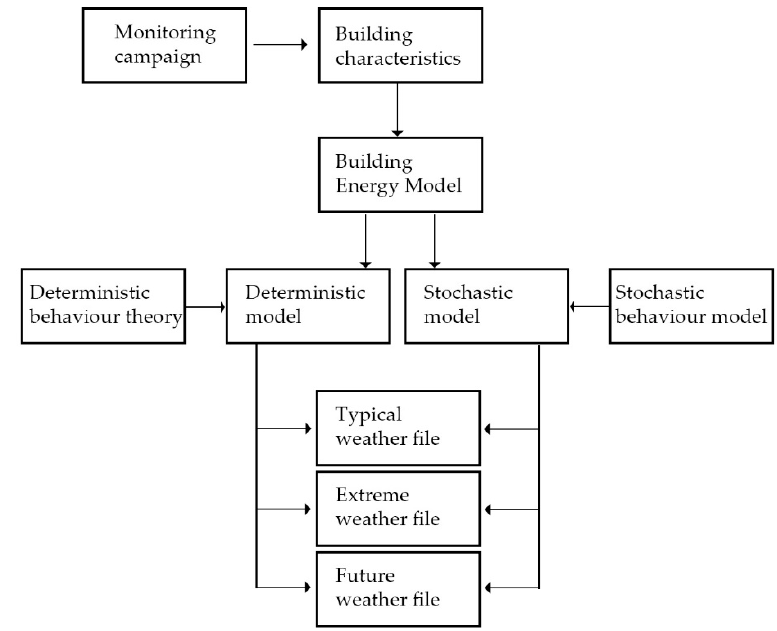
Figure 1. Conceptual framework of the study.